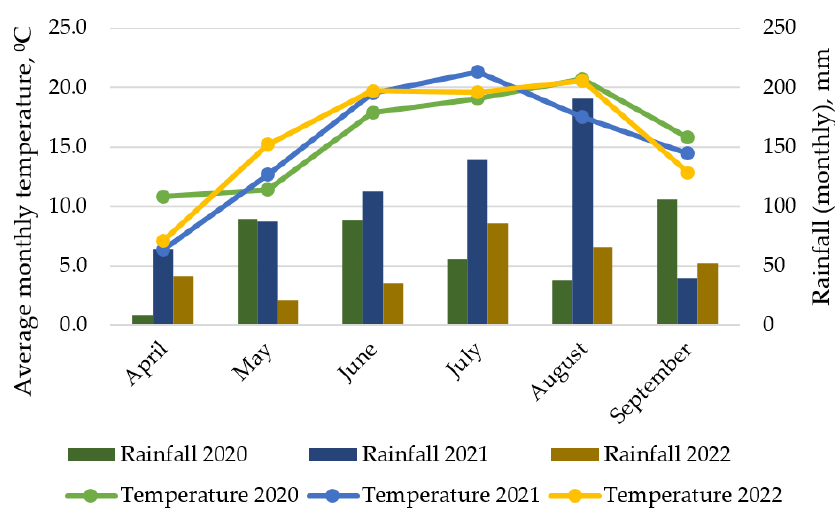
Figure 1. Weather conditions during the experiment. Table 3. Scale grades used for bonitation assessment of turf